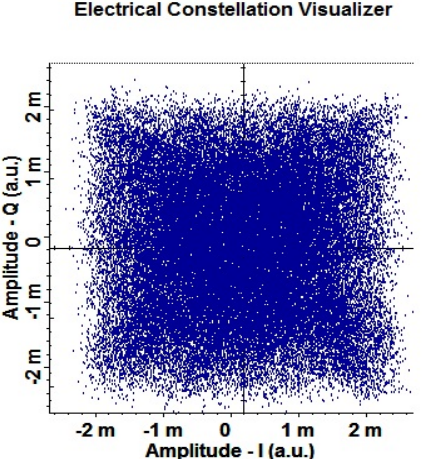
Figure 13. Highly distorted constellation of 256-QAM symbols at 22,000 km without DSP.